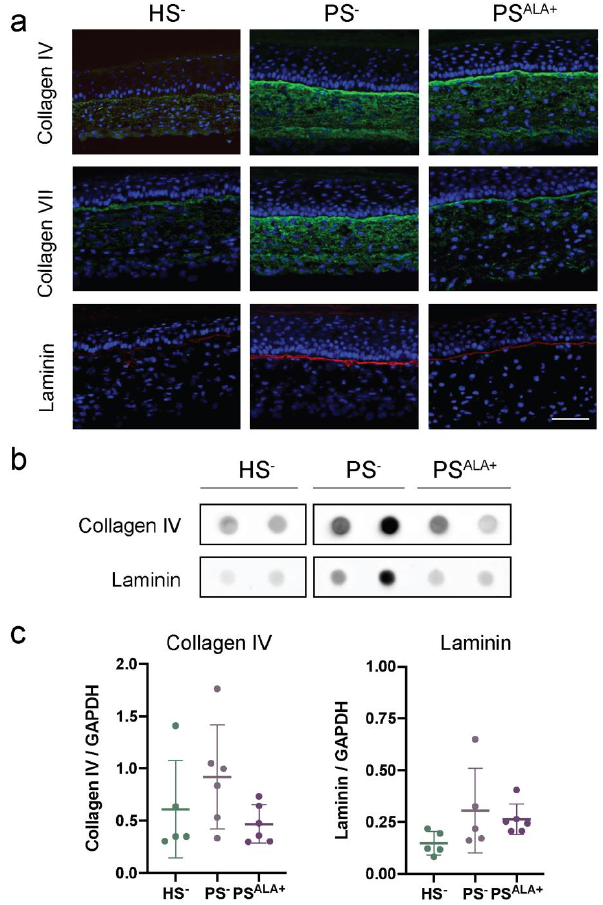
Figure 4. Impact of α -linolenic acid (ALA) supplementation on the levels of proteins at the dermo- epidermal junction of healthy and psoriatic skin substitutes. ( a ) Indirect immunofluorescence staining of collagen IV (green), collagen VII (green), and laminin (red). Nuclei were stained with DAPI (blue). Scale bar: 100 μm. ( b ) Dot blot analysis of collagen IV and laminin. ( c ) Densitometric analysis of the dot blot from panel ( b ) (N = 3 donors, n = 2 skin substitutes per donor). Statistical significance was determined using one- way ANOVA followed by Tukey’s post -hoc test. Abbreviations: ALA — α -linolenic acid; HODE — hydroxyoctadecadienoic acid; HS — healthy substitute; PS — psoriatic sub- stitute.